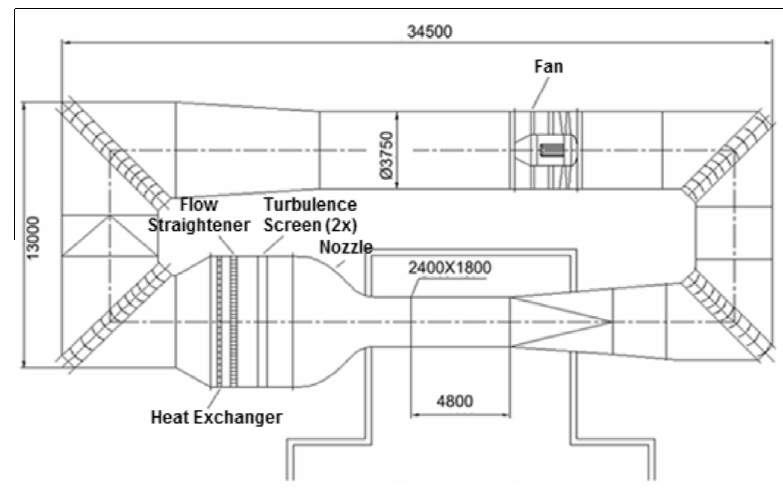
Figure 11. W/T–A facility at Technical University of Munich, Chair of Aerodynamics and Fluid Mechanics (TUM–AER), units